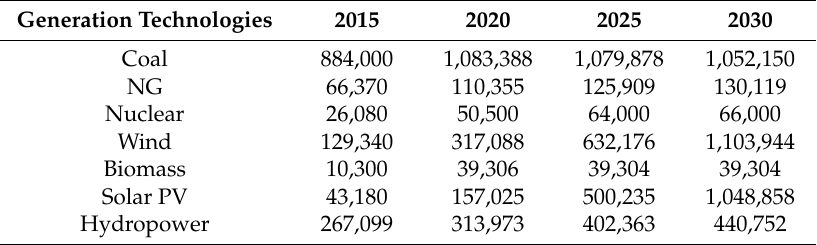
Table 7. Cumulative capacity deployments (in MW) for China in High Renewable Energy Penetration scenario [71].